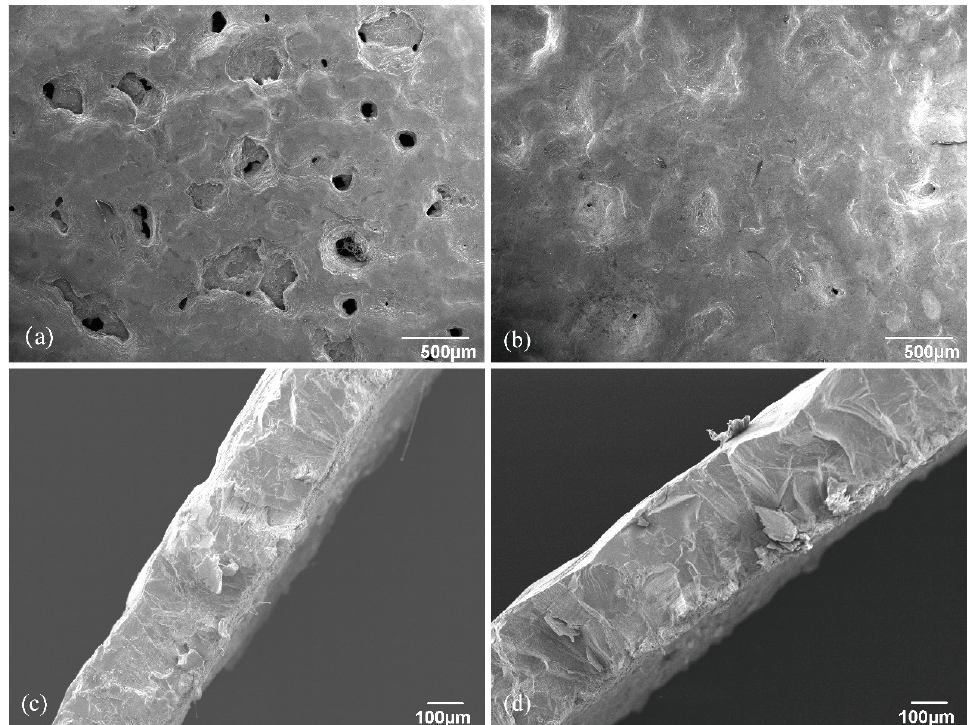
Figure 1. The outer surface of a Chinese alligator egg with erosion craters, some of which contain pores. The outer-shell surfaces of Chinese alligator eggs with low hatching rates ( a ) and high hatching rates ( b ), as well as the shell thickness of low-hatching-rate eggs ( c ) and high-hatching-rate eggs ( d ).